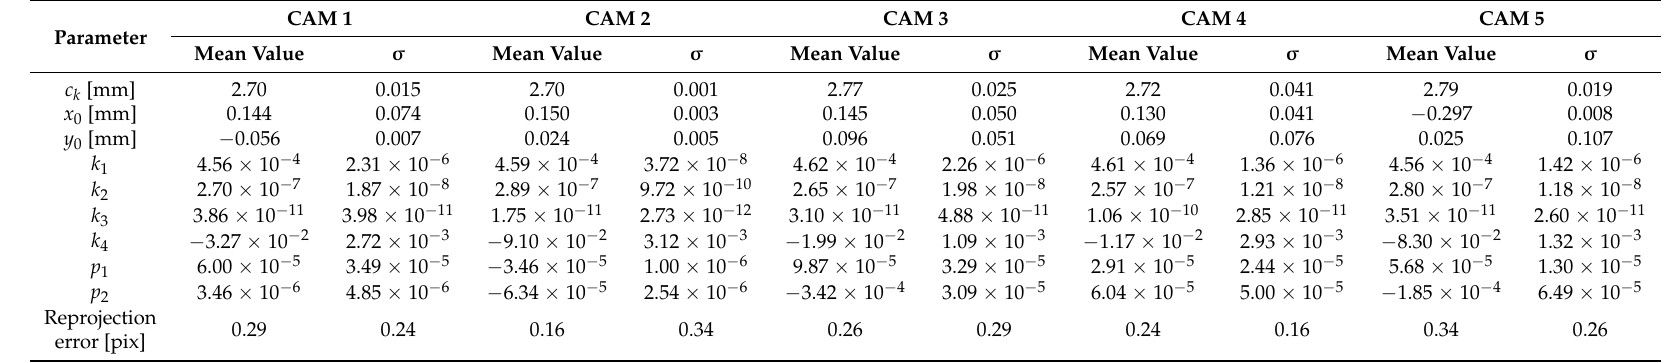
Table 3. Calibration results for five cameras for 2.7 K Video mode GoPro4 Hero